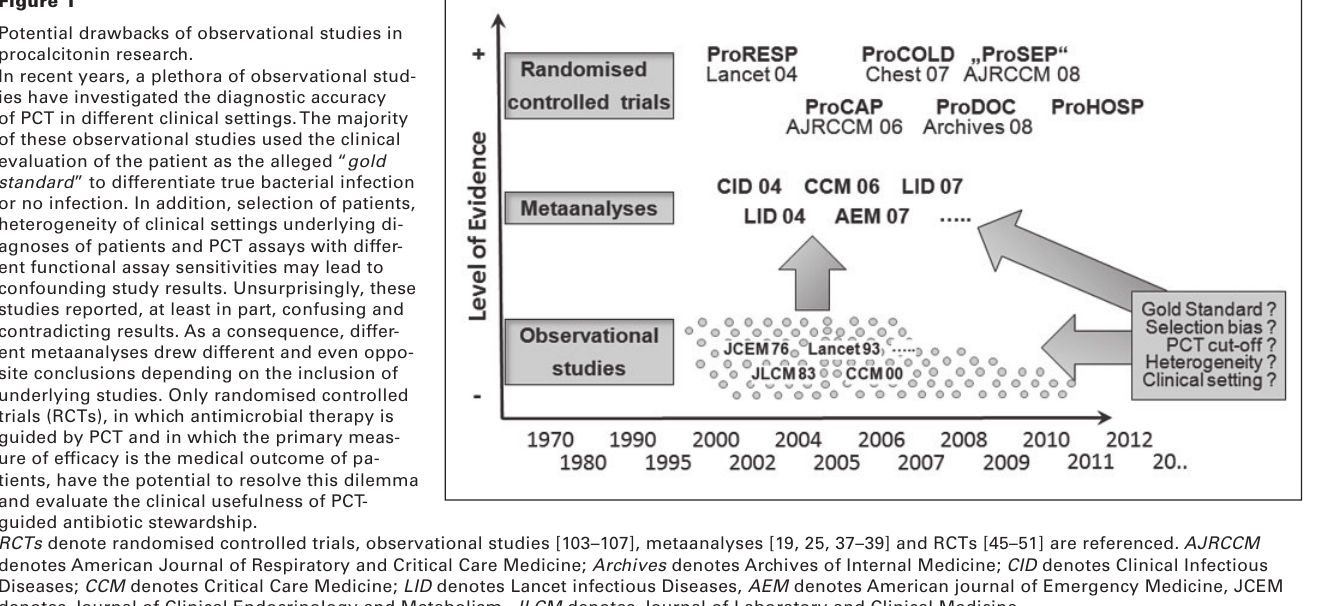
Potential drawbacks of observational studies in procalcitonin